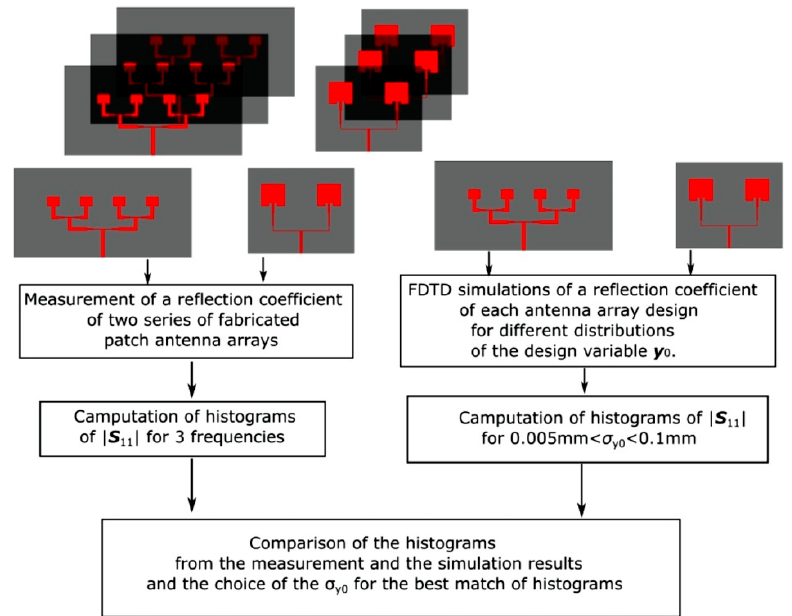
Figure 4. The illustration of the procedure of the extraction of the geometrical uncertainty of the PCB antenna manufacturing process. antenna manufacturing